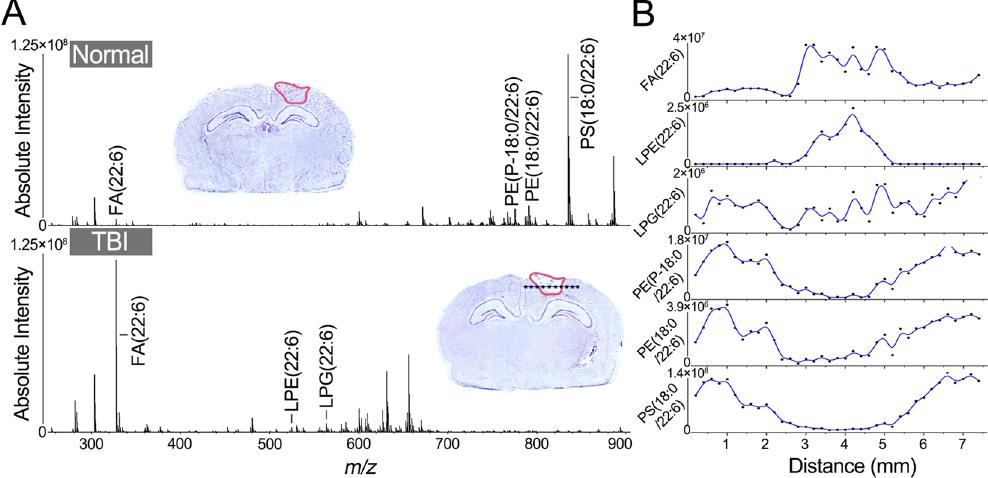
Figure 3. Tissue profiling on brain sections derived from TBI model and normal control. ( A ) Mass spectra acquired from the injury areas of TBI model (3 days post injury) and normal control. Cresyl violet staining of brain sections was shown in the side of mass spectra, and the injury area was circled with red line. ( B ) Plots of the absolute intensity of FA(22:6), LPE(22:6), LPG(22:6), PE(P-18:0/22:6), PE(18:0/22:6), and PS(18:0/22:6) along with the distance (mm) of black line which throughout the injury area of the optical image of TBI model of ( A